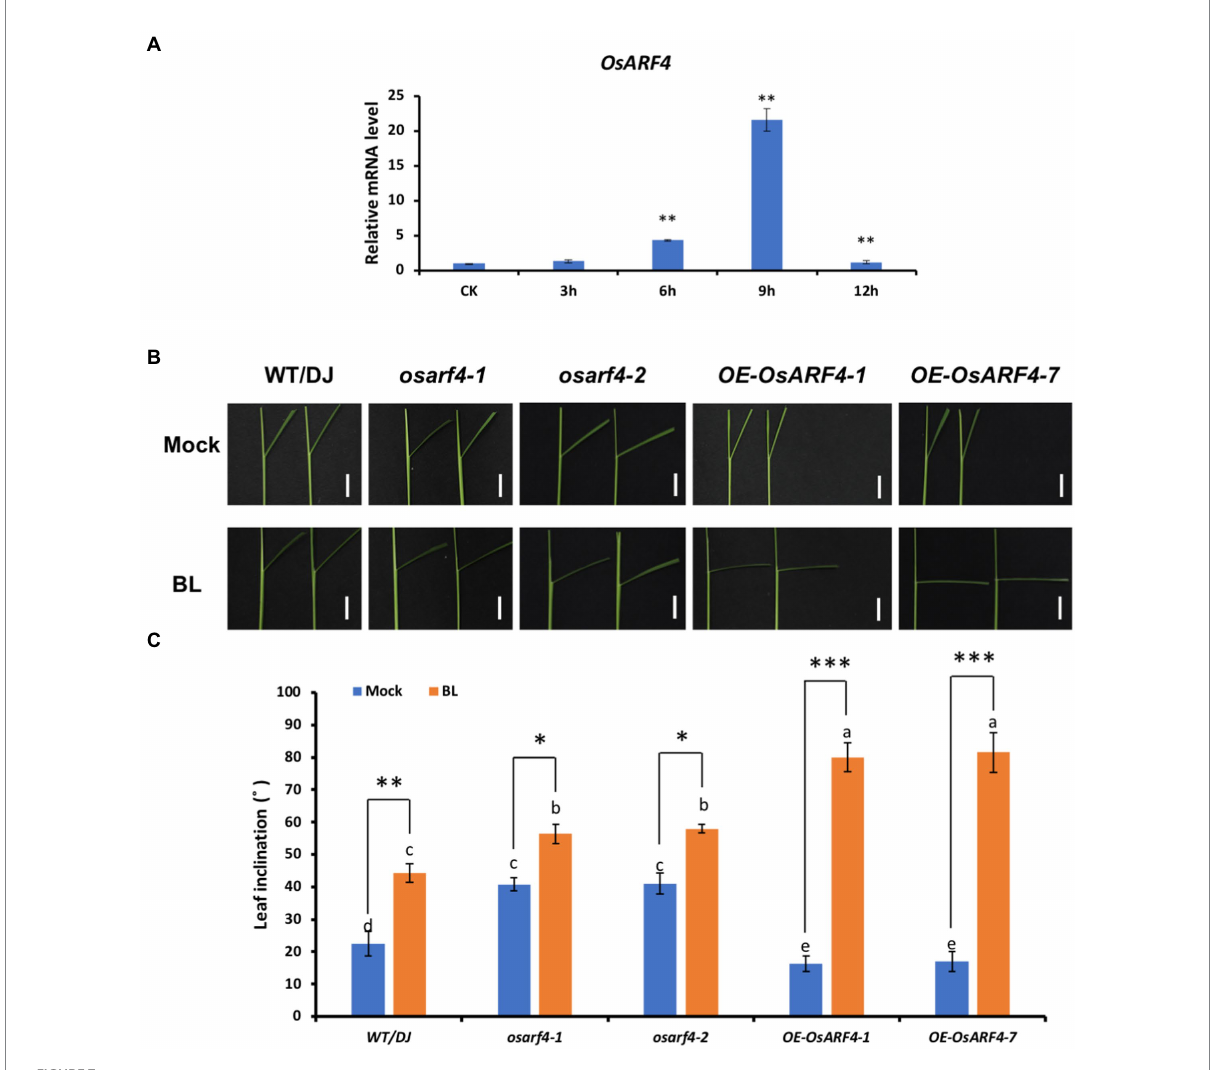
FIGURE 7 OsARF4 is sensitive to low concentration of BR in increasing leaf inclination of rice seedling. (A) The expression of OsARF4 under 0.1 μ m 24-eBL treatment at different time intervals. (B) Leaf inclination response of 7 days seedlings of WT/DJ, osarf4-1 , osarf4-2 , OE-OsARF4-1 , and OE-OsARF4-7 to 0.1 μ m 24-eBL treatment for 3 days. (C) Measurement of leaf inclination in response to 0.1 μ m 24-eBL treatment for 3 days as shown in B . Fifteen rice lines were measured for each treatment. Error bars indicate SD ( n = 3). Lowercase letters represent significance based on Duncan’s multiple range test ( 𝛼 = 0.05). * p < 0.05, ** p < 0.01 and *** p < 0.001 indicate significant differences of means ± SD compared with control based on t